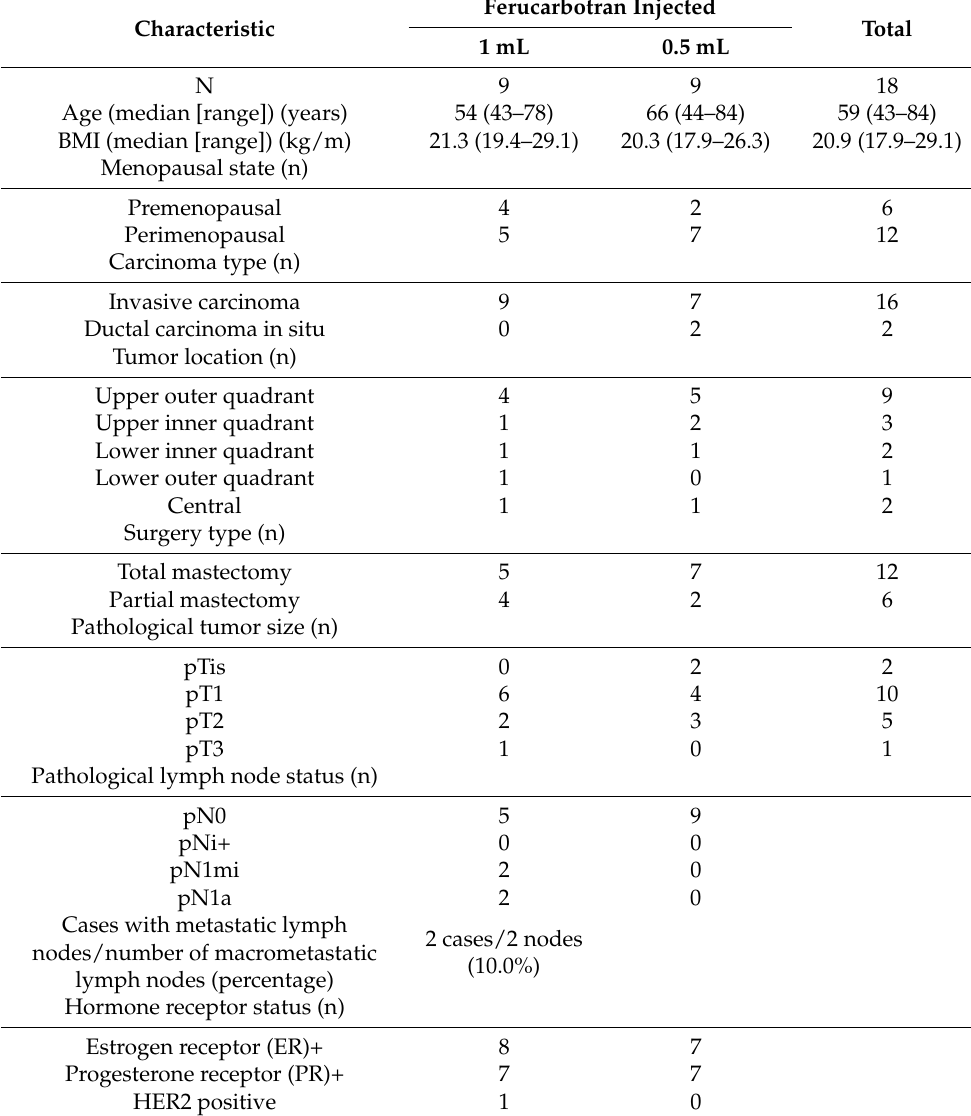
Table 1. Patient and pathological